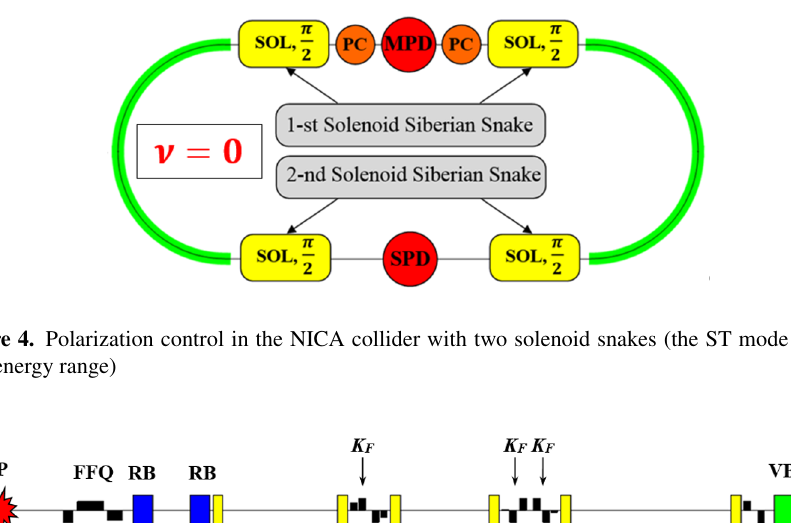
(defocusing) quadrupole lenses. A possible scheme of the distributed snake (one half) based on short 6 T superconducting solenoids (SC) is shown in Fig.